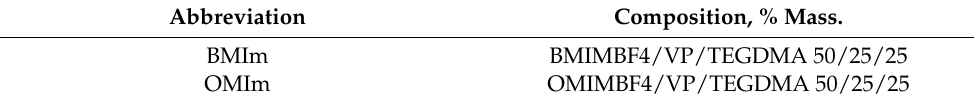
Table 2. Photopolymer